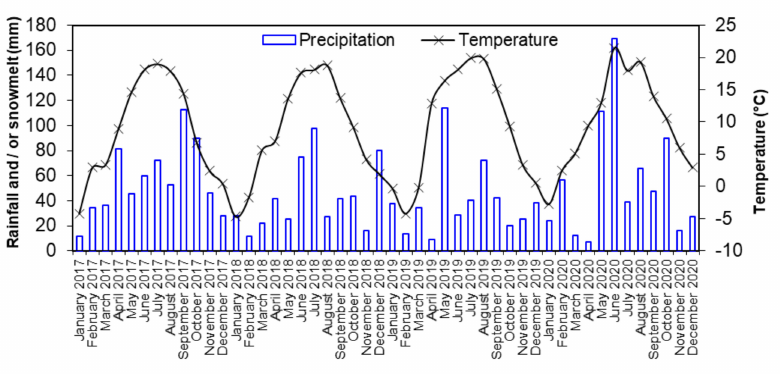
Figure 1. Monthly average air temperatures and sums of precipitation during the period of